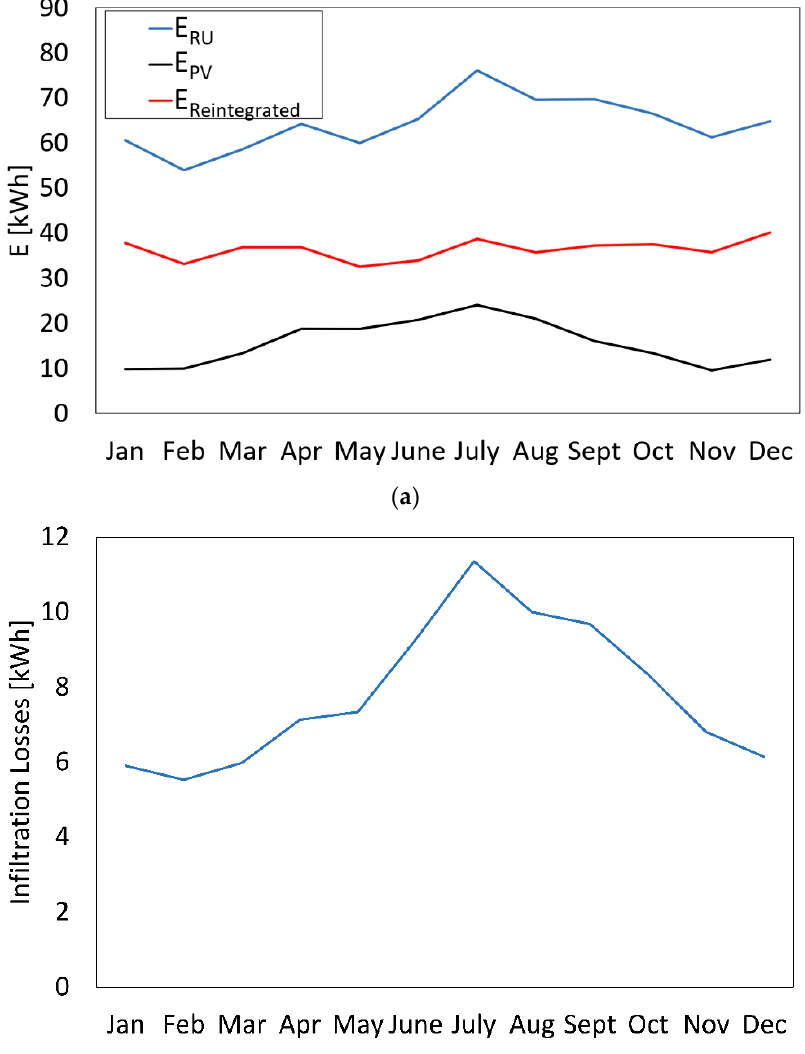
Figure 11. Monthly electricity absorbed by the refrigeration unit, produced by the PV system and reintegration from the grid ( a ) and monthly infiltration losses during the unloading operations of the products in each delivery ( b ).